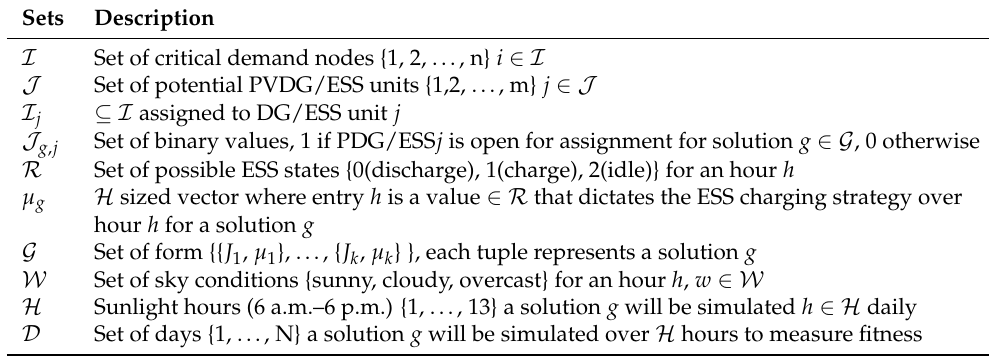
Table 1. Sets used for MG model and